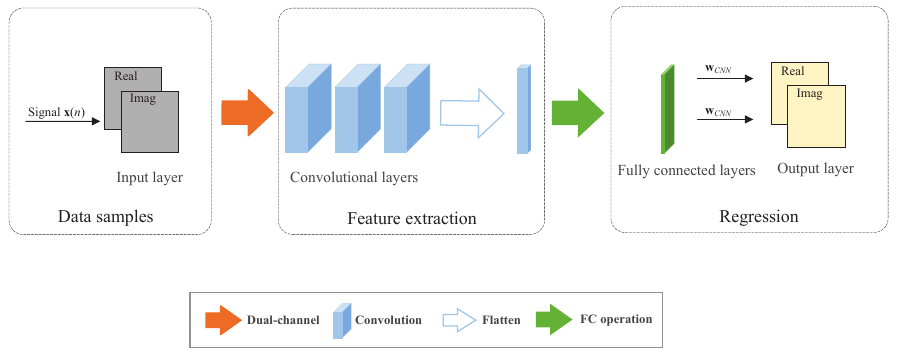
Figure 2. The WBPNet